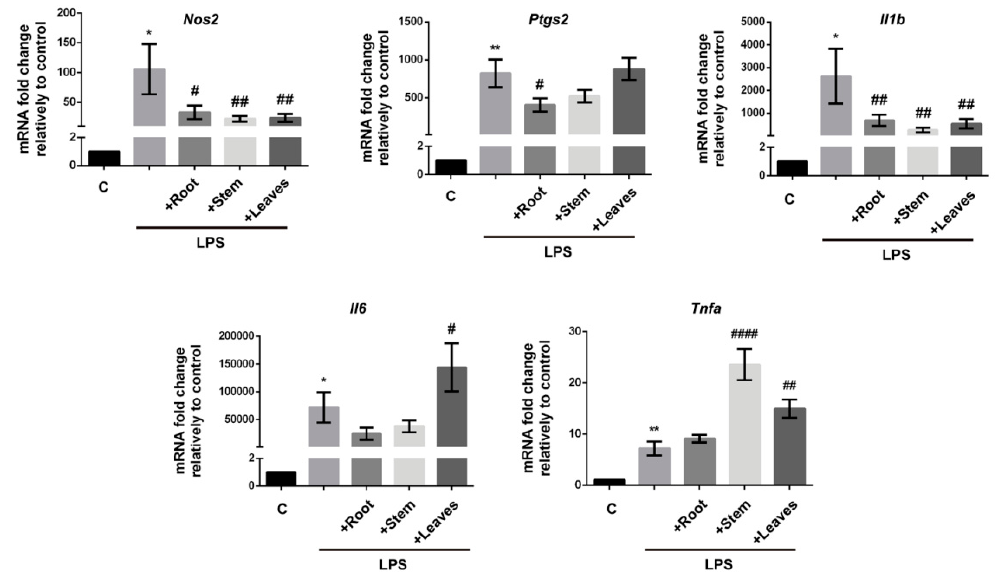
Figure 4. Effects of G. tridentata extracts over LPS-induced transcription of Nos2 , Ptgs2 , Il1b , Il6, and Tnfa genes. Cells were exposed to extracts from root, stem, and leaves and then stimulated with LPS. After 24 h the mRNA was extracted and the gene transcription was assessed by q-PCR. Data is presented as mRNA fold change relatively to untreated cells (C) and represent the mean ± SD from three independent experiments. (* p < 0.05; ** p < 0.01: C vs. LPS; # p < 0.05; ## p < 0.01; #### p < 0.0001: LPS vs. extracts + LPS).